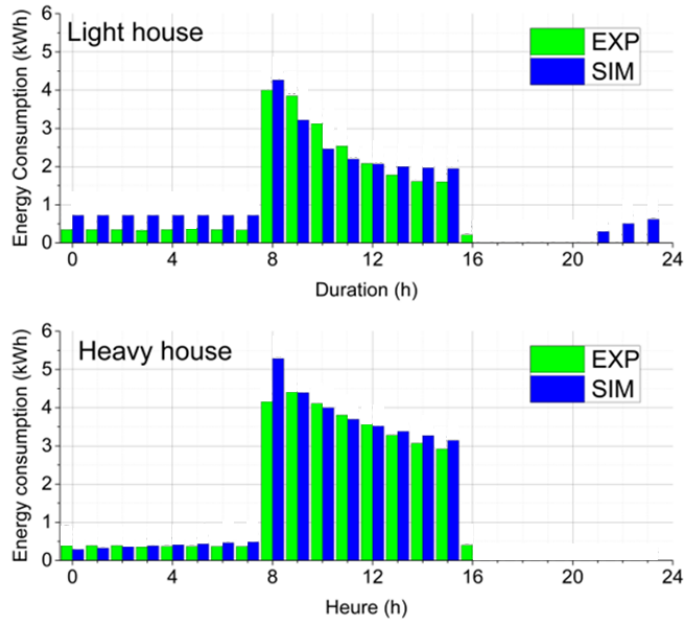
Figure 19. Energy consumption of the heaters for both thermal mass envelopes in simulation and in the experimentation